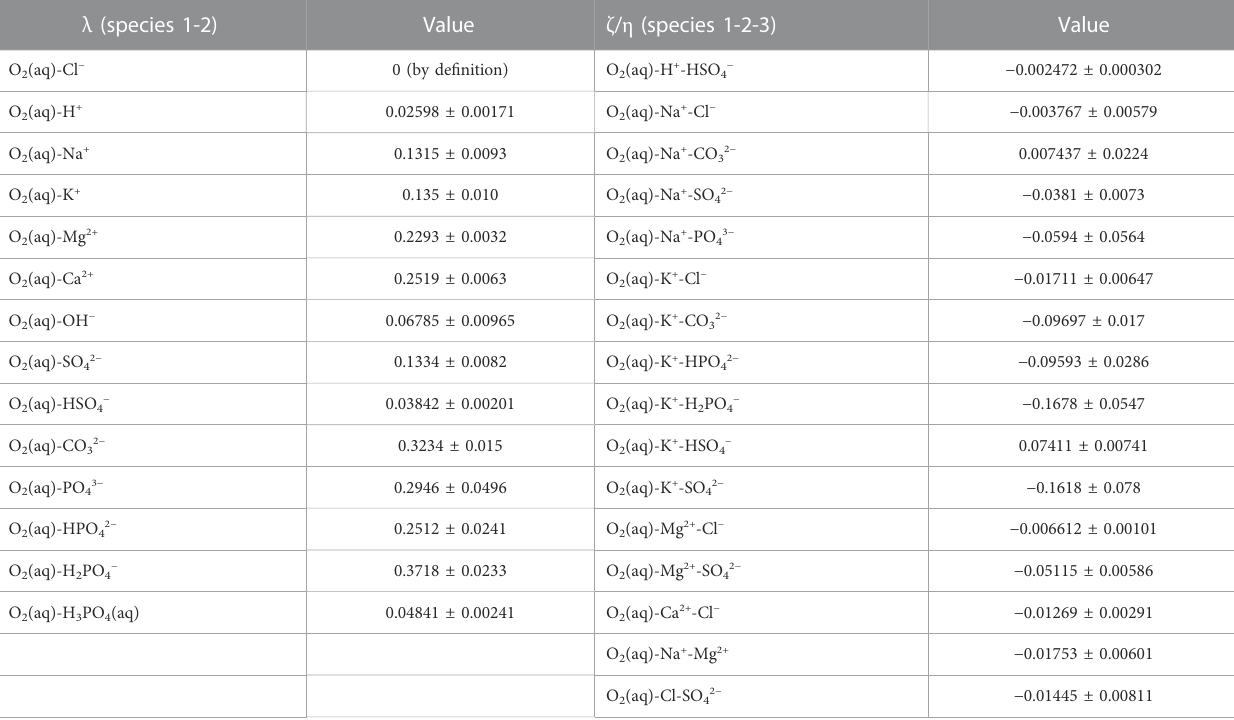
TABLE 8Binary and ternary ion-neutral speciesinteractioncoef fi cients ( λ , ζ , η ) for the solubility of O 2 insalt solutionsatT= 298.15 K.The uncertainty information refers to one standard deviation. λ (species